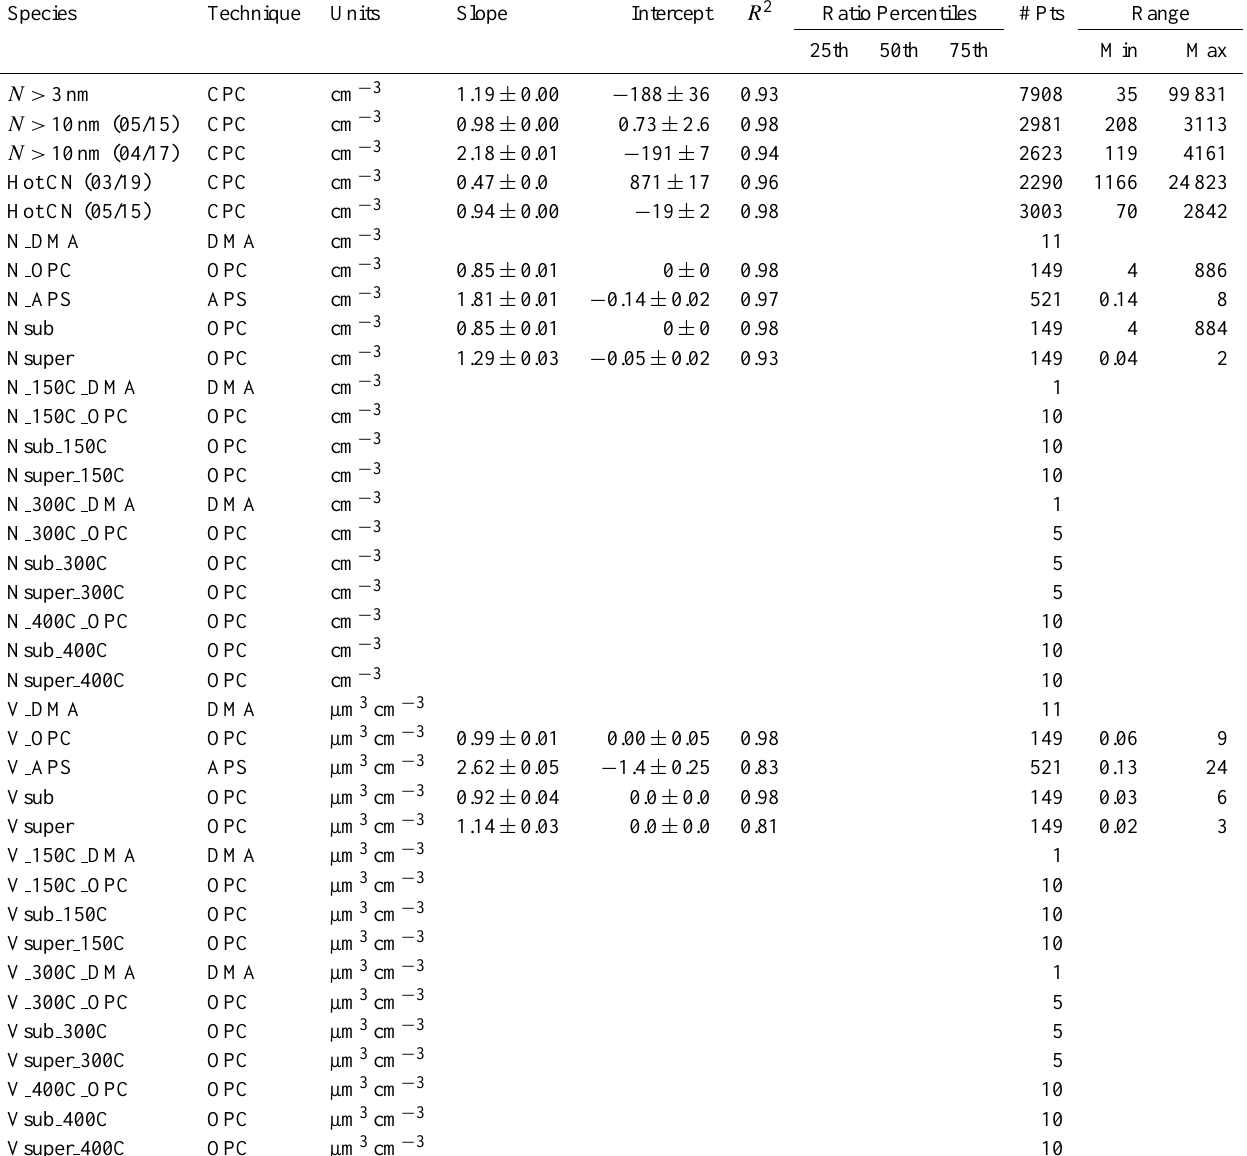
Table 3g. Statistical results of DC-8/C-130 intercomparison. Particle microphysical properties. NOTE: Technique is listed as X (C-130) vs. Y (DC-8).